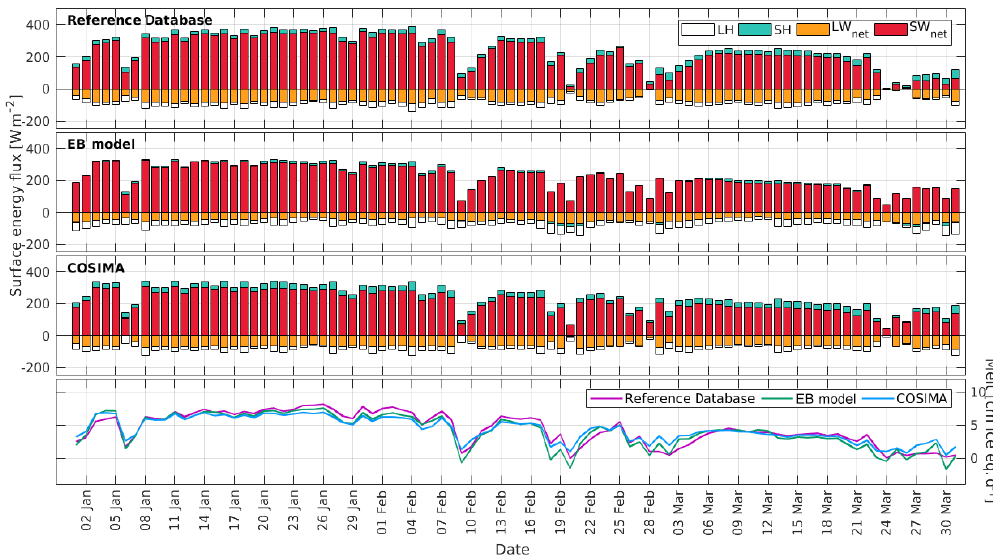
Figure 6. Daily modeled and measured energy fluxes and inferred daily melt rates during summer 2015 for Bello Glacier using the three methods.